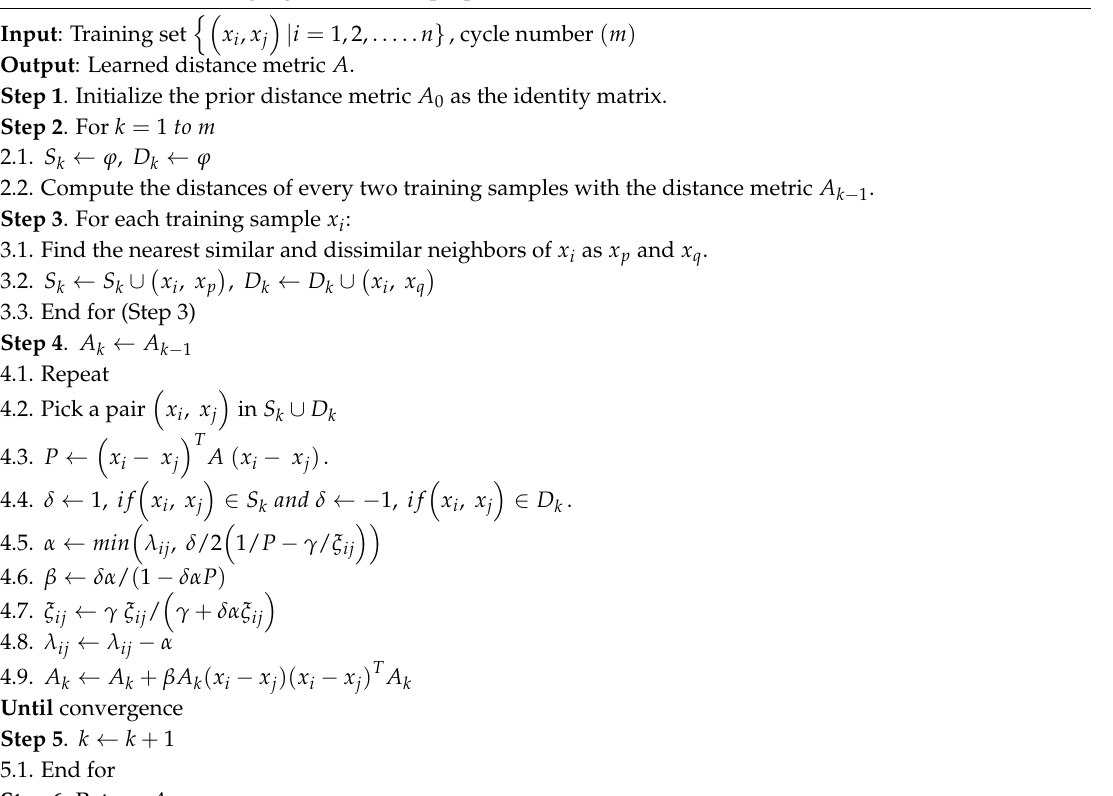
Algorithm 1. The training algorithm of the proposed